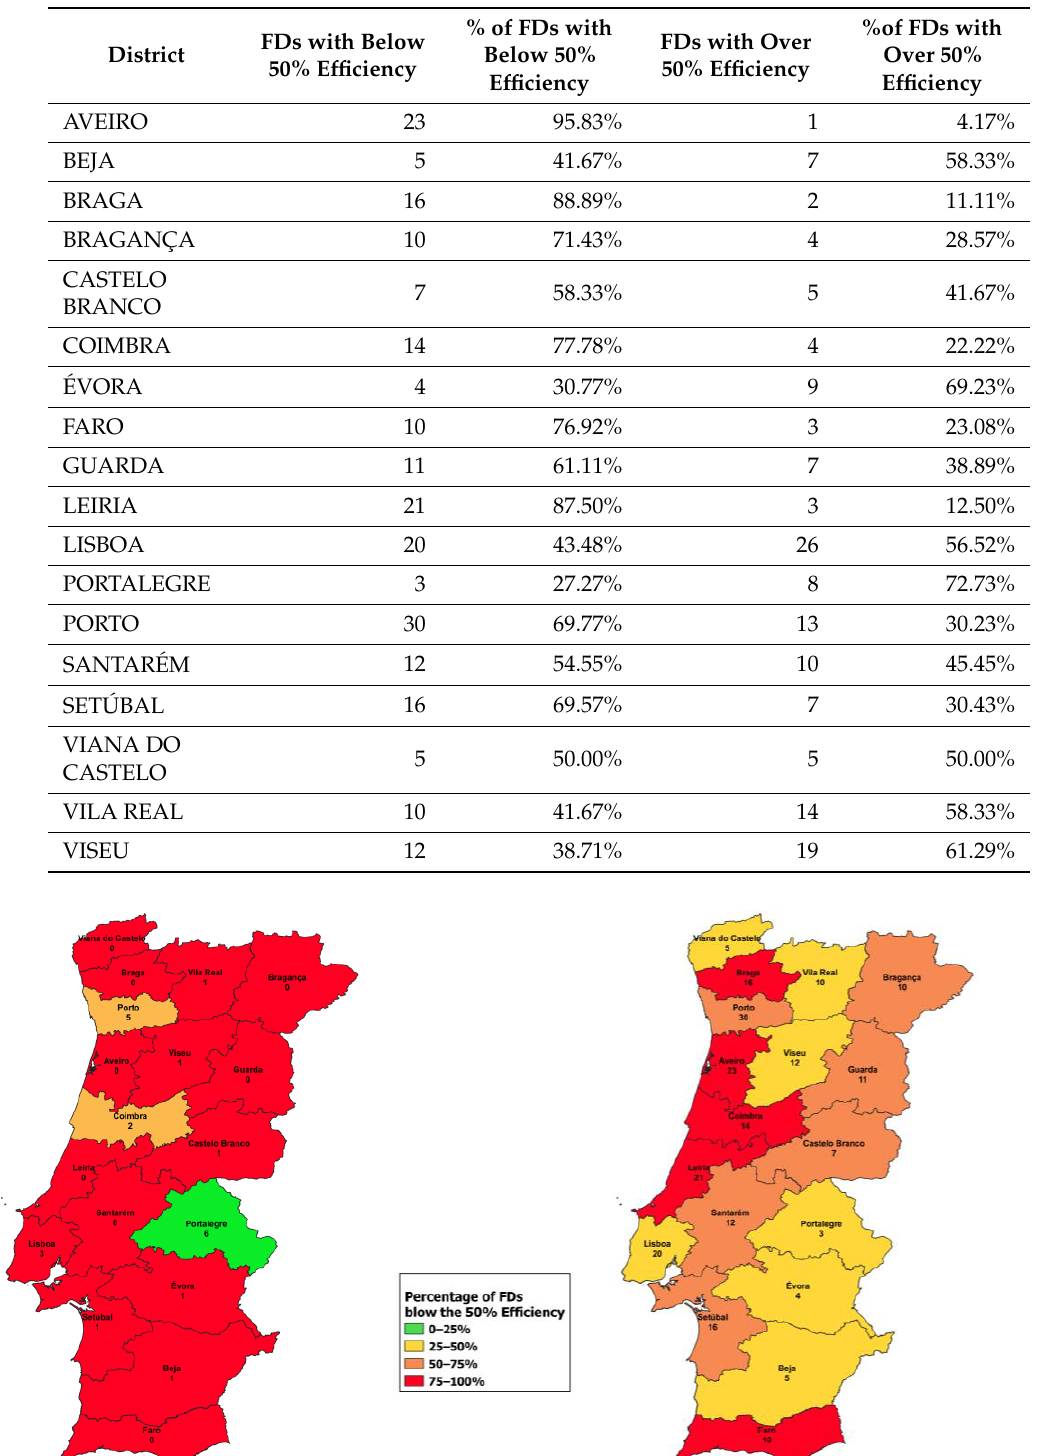
Table 5. Number and percentage of efficient FDs below and over 50% efficiency in each 18 districts of Portugal (except islands).